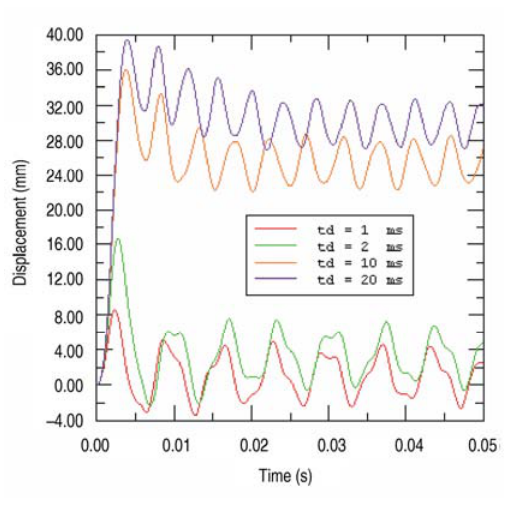
Fig. 6. Influence of loading duration for model